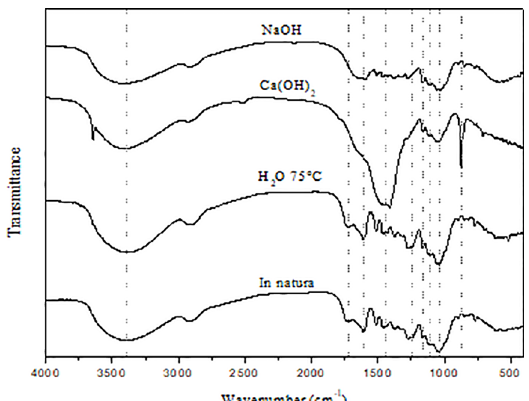
Figure 1. FTIR spectra of the piassava fiber "in natura" and after different surface treatments.